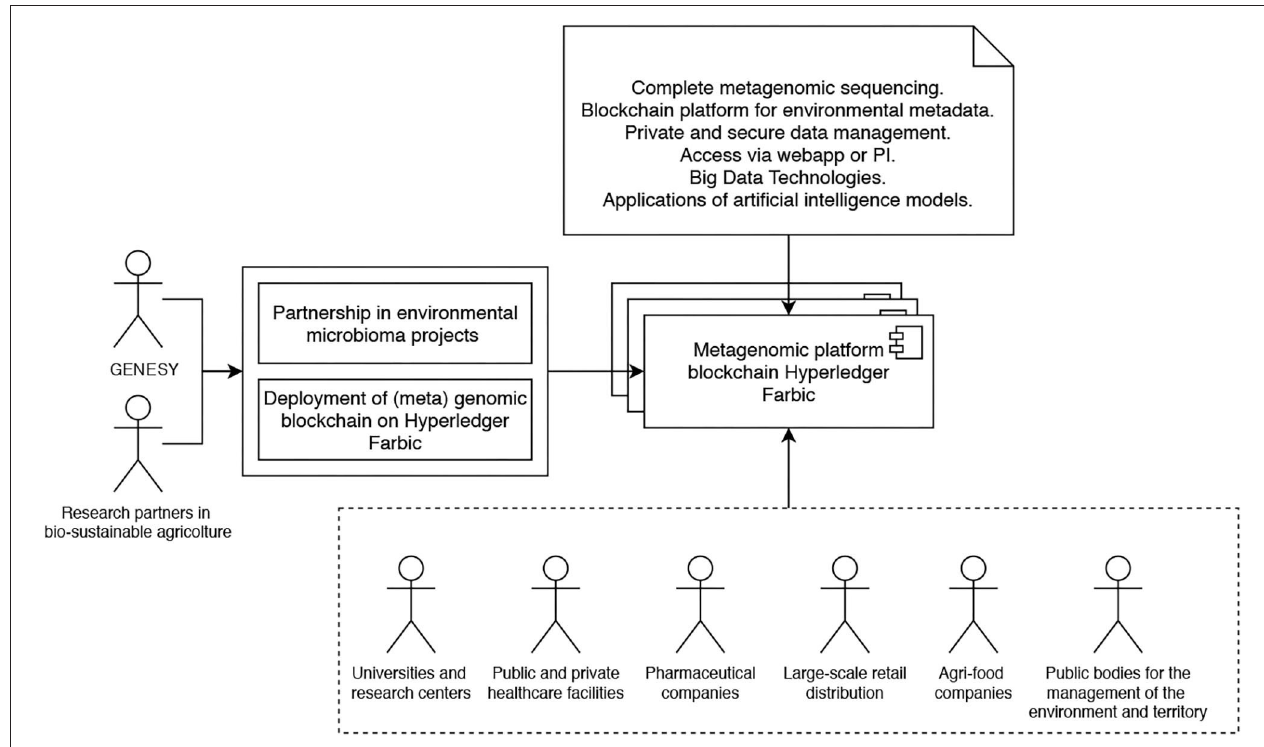
FIGURE 1 | Overview of the main components as well as the roles of the various stakeholders of reference in the Genesy consortium architecture.